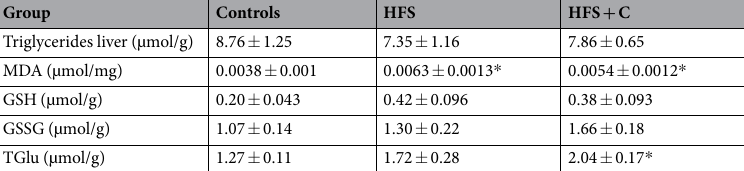
Table 1. Triglycerides, MDA and glutathion concentrations in liver samples. HFS high fructose and saturated fatty acids, C curcuma (administration of hydroalcoholic extract of tumeric 100 mg/kg/day). MDA Malondialdehyde; TGlu: Total glutathione (GSH + GSSG); GSH: reduced glutathione; GSSG: oxidized glutathione. Values are mean ± S.E.M (n = 6–12 rats/group). * P < 0.05 vs. the